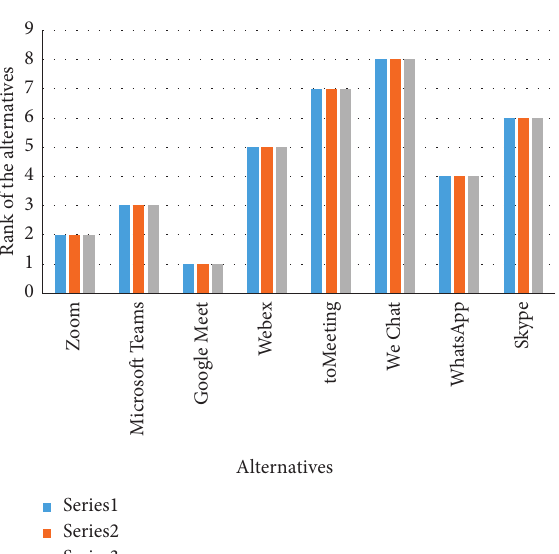
Figure 2: Results of the comparison of results of different MCDM algorithms (Series 1: PF-PROBID; Series 2: PF-TOPSIS; Series 3: